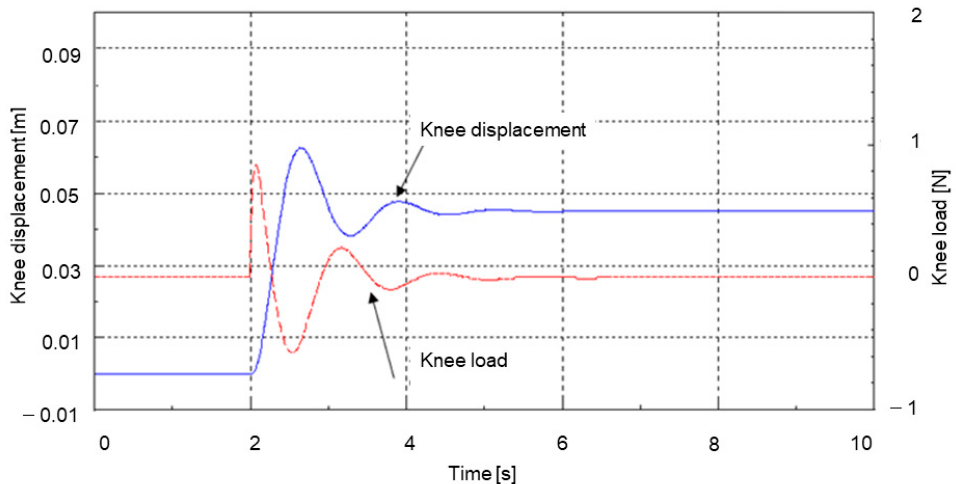
Figure 15. Fundamental model calculation result with device.